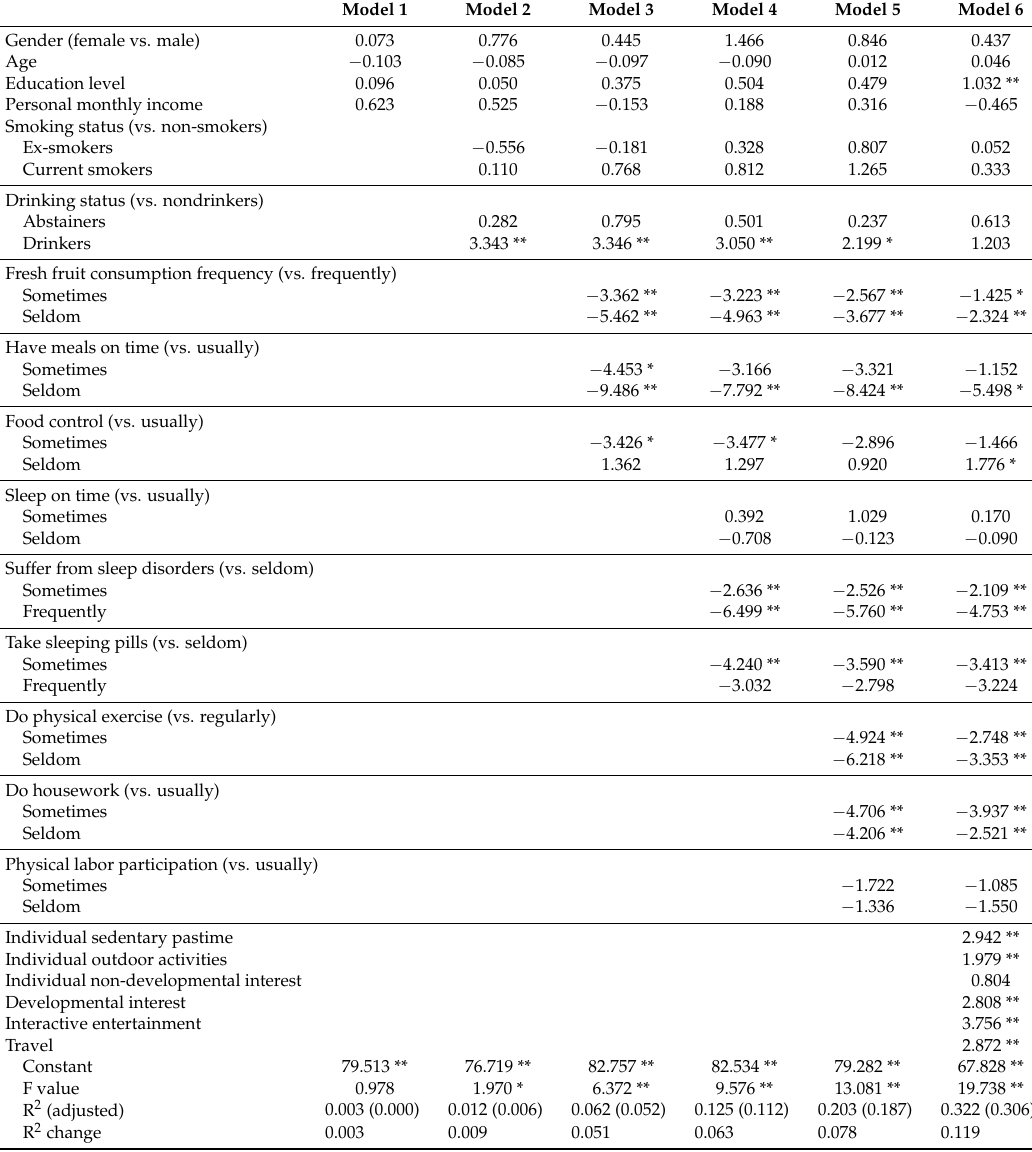
Table 5. Hierarchical linear regression models of the total score of the